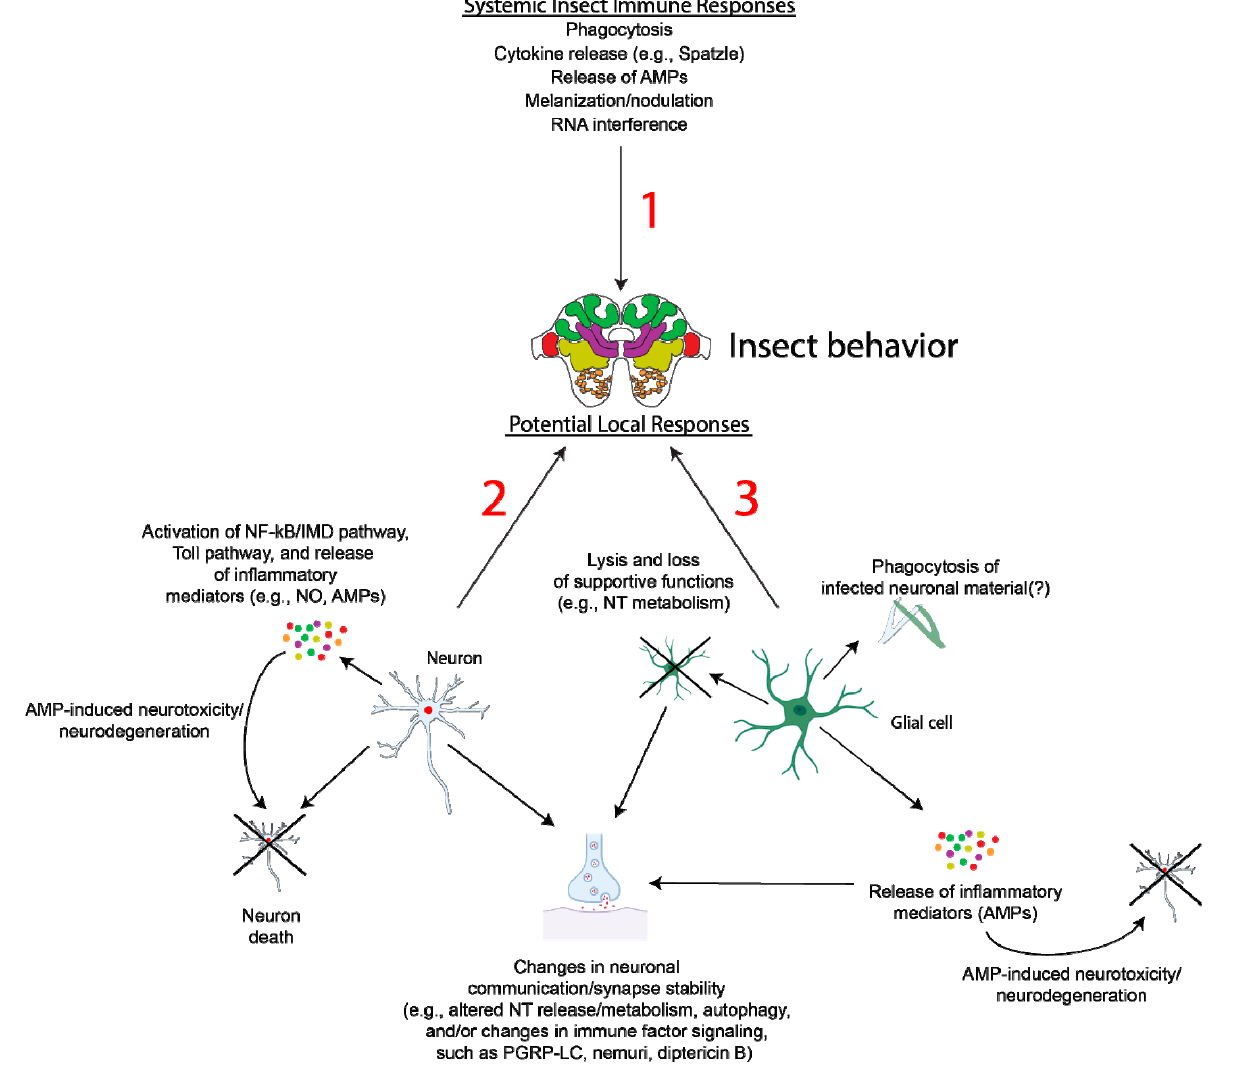
Figure 3. Potential alterations in local immune responses and relationship with insect behavior. While there is the potential for cross-talk between immune modulators such as AMPs, cytokines, etc., and the nervous system (1), the detailed existence of this cross-talk as well as any impacts on insect behavior in behavioral manipulator insect systems remain to be fully detailed. During infection by a behavioral manipulator (e.g., O. kimflemingiae ) or interaction with a parasitoid (e.g., A. compressa ), local inflammatory reactions by neurons (2) and/or glia (3) to pathogens or parasitoid-related injury may cause neuron damage and degeneration, potentially via the release of AMPs (e.g., metchnikown, drosomysin, and defensin). Degeneration of glia may cause loss of supportive functions and altered neurotransmitter (NT) release or metabolism. Additionally, specific AMPs are functionally pleiotropic in Drosophila , including peptidoglycan recognition protein LC (PGRP-LC), nemuri, and diptericin B, which contribute to the regulation of presynaptic homeostatic plasticity, sleep, and memory formation, respectively [159,163,165]. Alterations in the expression of such AMPs by neurons and/or glia may, therefore, directly impact neuron communication and the regulation of synaptic stability. Changes in neuronal autophagy, as has been observed in Zika-infected Drosophila [148], may also impact synapse structure, as autophagy plays key roles in synapse development [173]. It is unclear whether infection or injury triggers aberrant glia-dependent phagocytosis of neuronal material and this requires further investigation. These hypotheses remain to be tested in the models described here and may prove to be exciting areas for future research in the field of behavioral manipulation in insects. Images created with BioRender.com (accessed on 15 January